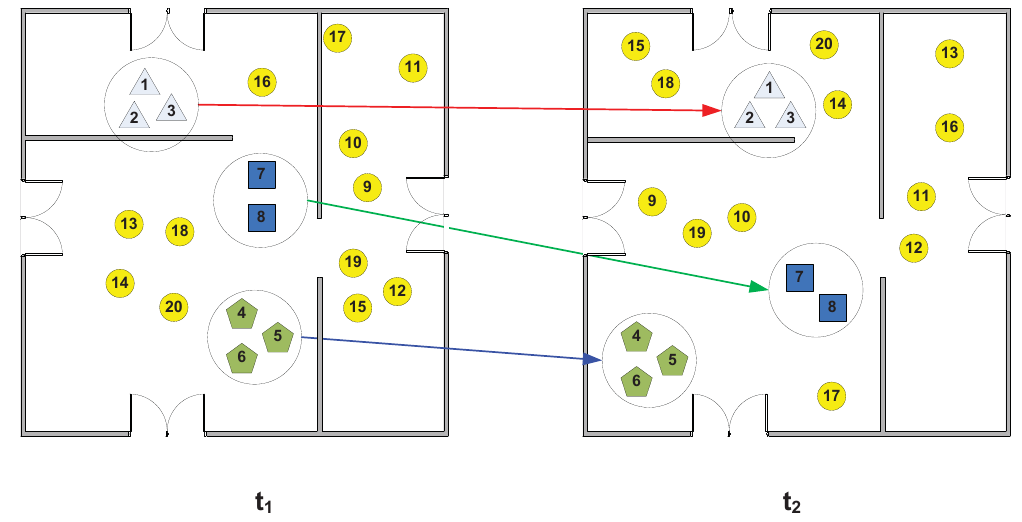
Figure 1. An illustration of mobile group consumption. Several people wander around a shopping mall with different regions. Each person is denoted by a node, and those belonging to groups have the same shape, except for the circle. The circle nodes denote the people who do not belong to groups ( i.e ., individuals). The picture on the left is a snapshot of people at timestamp t 1 , and the picture on the right is a snapshot of people at timestamp t 2 after t 1